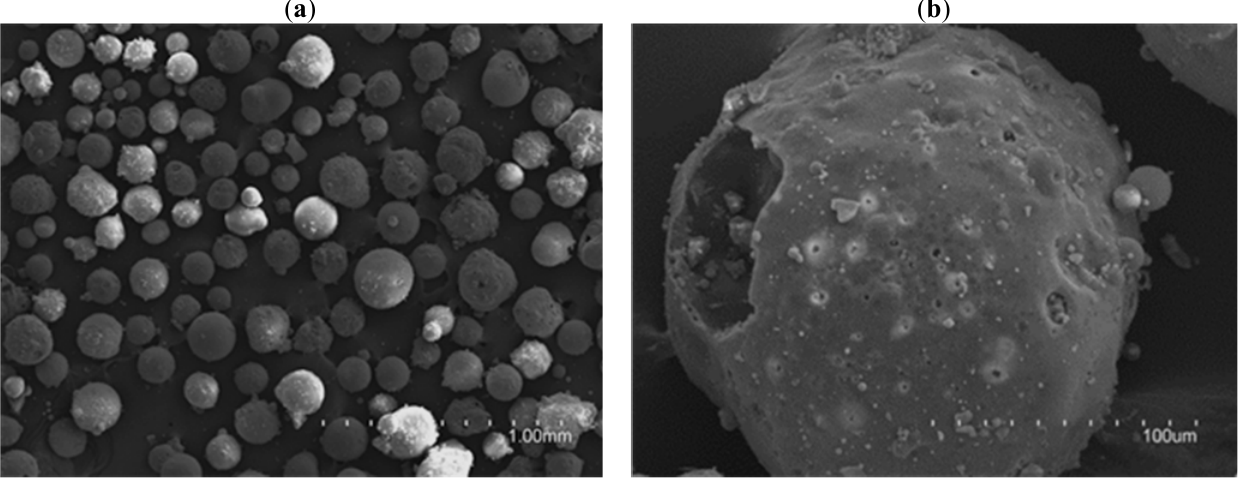
Figure 2. ( a ) Fly ash cenospheres; ( b ) Defects present in some cenospheres may include irregular shape, nonuniform wall thickness, and porous walls.